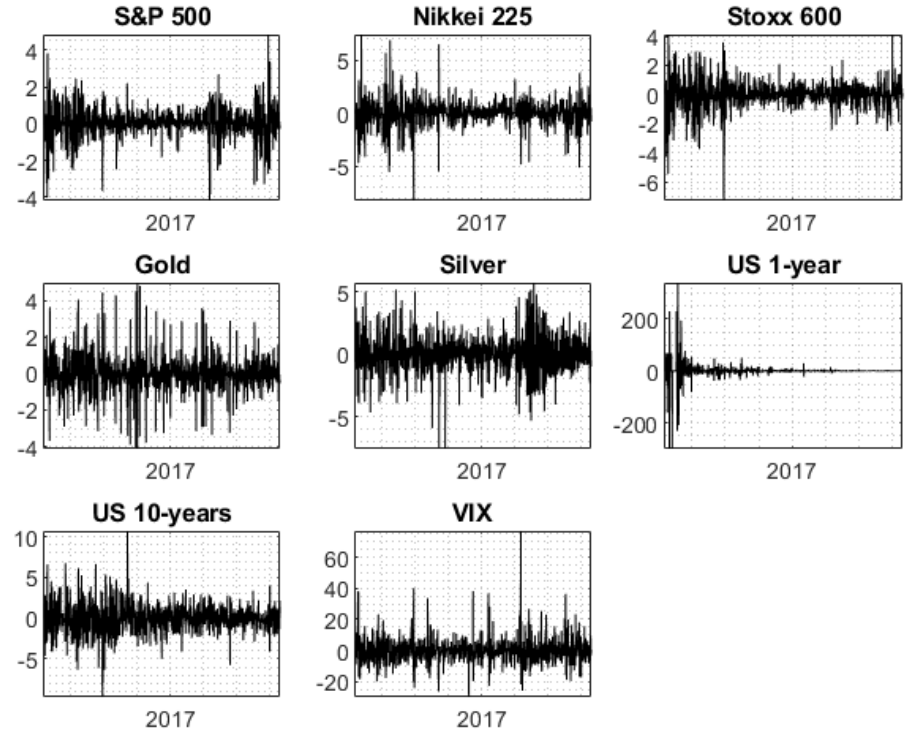
Figure 3. Daily log returns of the eight cryptopredictors from 8 August 2015 to 28 February